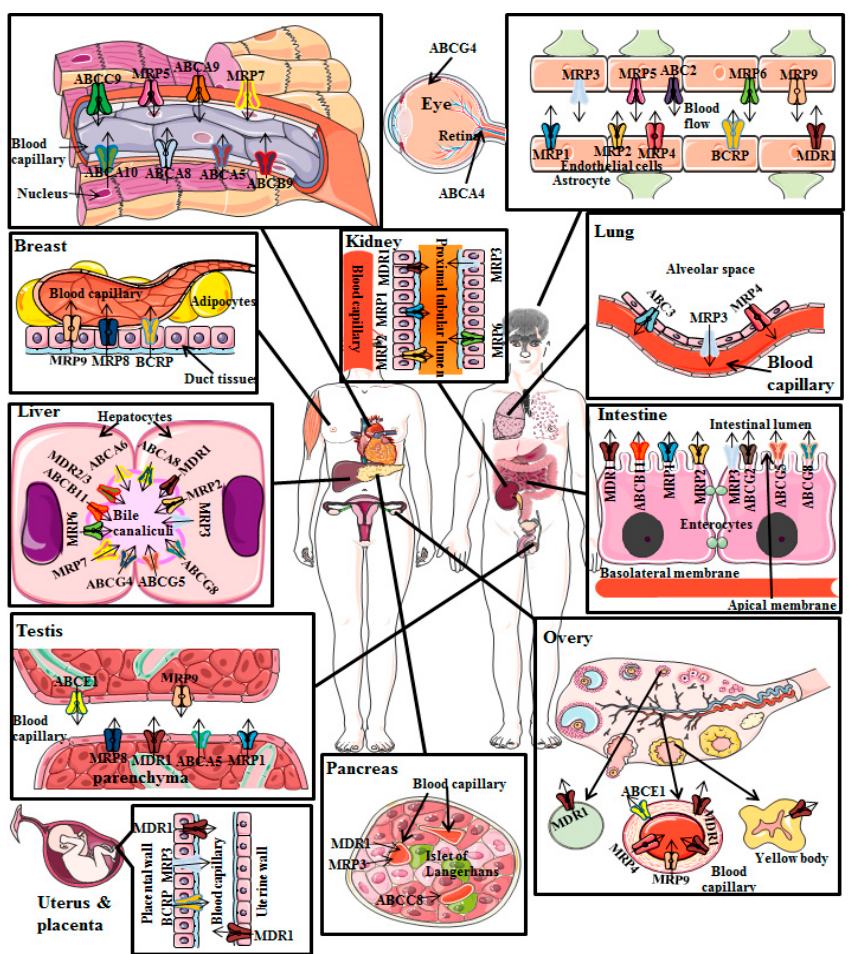
Figure 2. Overview of P-gp functional expressions throughout the body. Black lines indicate the location of ABCB1. Small arrows indicate the direction of ABCB1-mediated transport [9,10,22–26].